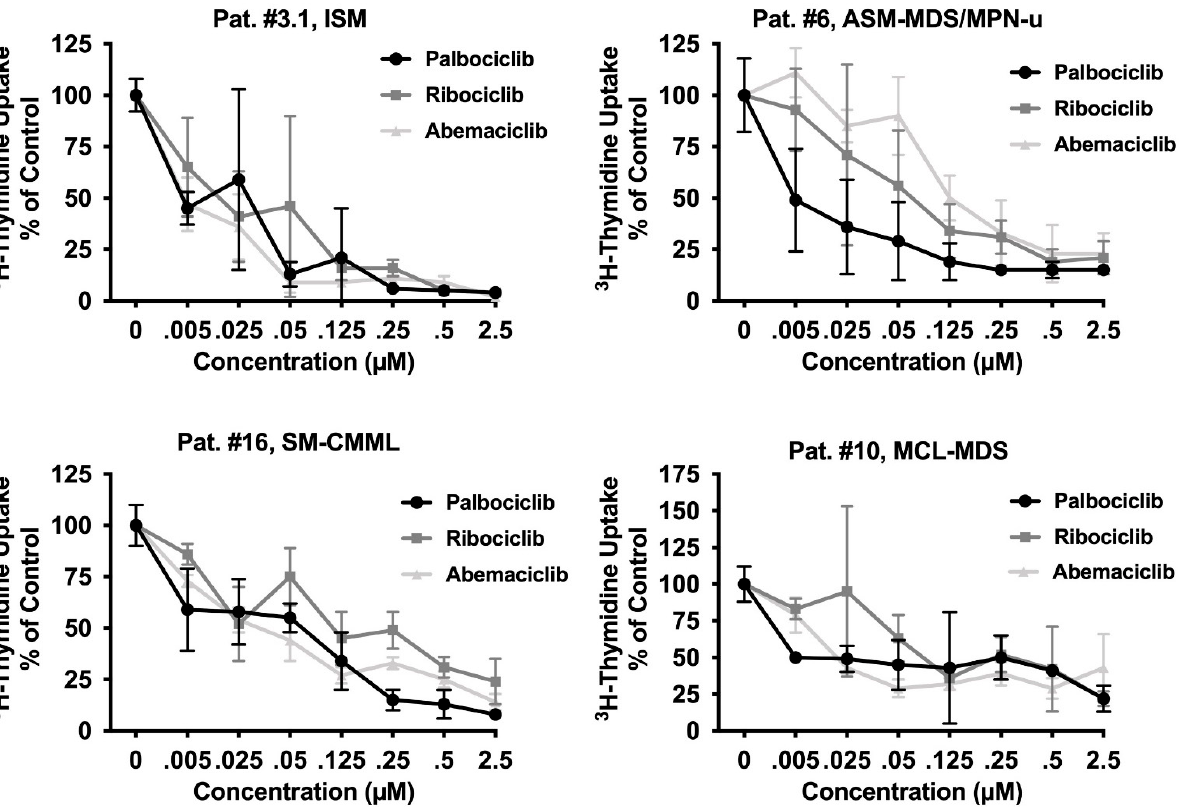
Figure 3. CDK4/CDK6 inhibitors induce growth arrest in primary neoplastic MC. Primary neoplastic MC obtained from one patient with ISM and three patients with AdvSM (as indicated) were incubated in control medium (0 nM) or medium containing various concentrations of palbociclib, ribociclib, or abemaciclib as indicated, at 37 °C for 48 h. Thereafter, 3 H-thymidine uptake was measured. Results are expressed as percentage of control and represent the mean ± S.D from triplicates. Statistical significance was reached in all experiments, as analyzed by ANOVA and post-testing by Dunnett test (Supplementary Materials, Table S8). The patient’s number refers to Table 1. Abbreviations: SM, systemic mastocytosis; ISM, indolent SM; ASM, aggressive SM; MCL, mast cell leukemia, AML, acute myeloid leukemia; MDS, myelodysplastic syndrome; MPN, myeloproliferative neoplasm; CMML, chronic monomyelocytic leukemia; u, unspecified; µM,